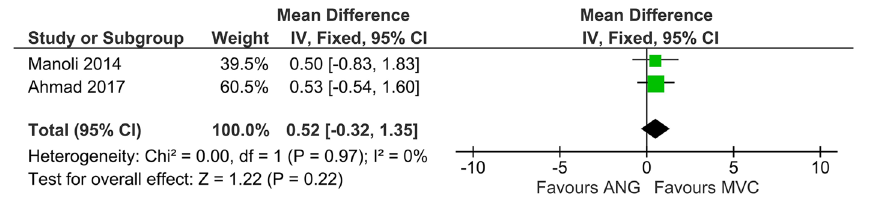
Figure 5. Meta-analysis of static two-point discrimination (clinical). There was no significant effect (p = 0.22) of the reconstructive method on static two-point discrimination detectable. No heterogeneity among the analyzed studies was detectable (I 2 = 0%). Note that while the estimated effects of interventions for both studies were only slightly different (0.53 vs 0.50), Ahmad’s study was given more weight and therefore more influence on the average effect of interventions due to the narrower confidence interval in comparison to Manoli’s work (2.14 vs.